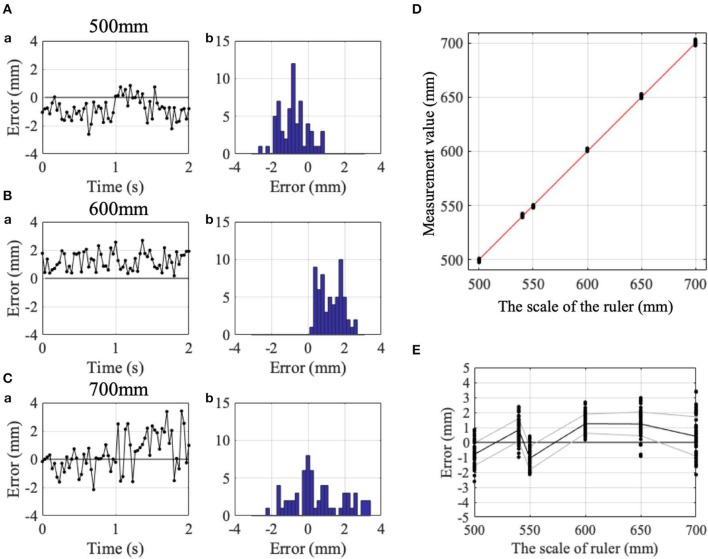
Accuracy and precision of the Kinect v2. (Aa) Change in detection errors with time and (Ab) their histogram, while IF was kept at the 500 mm point on the ruler. (Ba) Similar change in detection errors with time and (Bb) their histogram at the 600 mm point on the ruler. (Ca) Similar change in detection errors with time and (Cb) their histogram at the 700 mm point on the ruler. (D) Comparison of the read of the ruler (abscissa) and the measurement value obtained from the Kinect v2 (ordinate). Red dashed line indicates the identity line. (E) Error between the measurement value and the read of the ruler. Black and gray lines indicate means and standard deviations. Positive and negative values showed horizontal positions rightward and leftward as shown in, respectively.